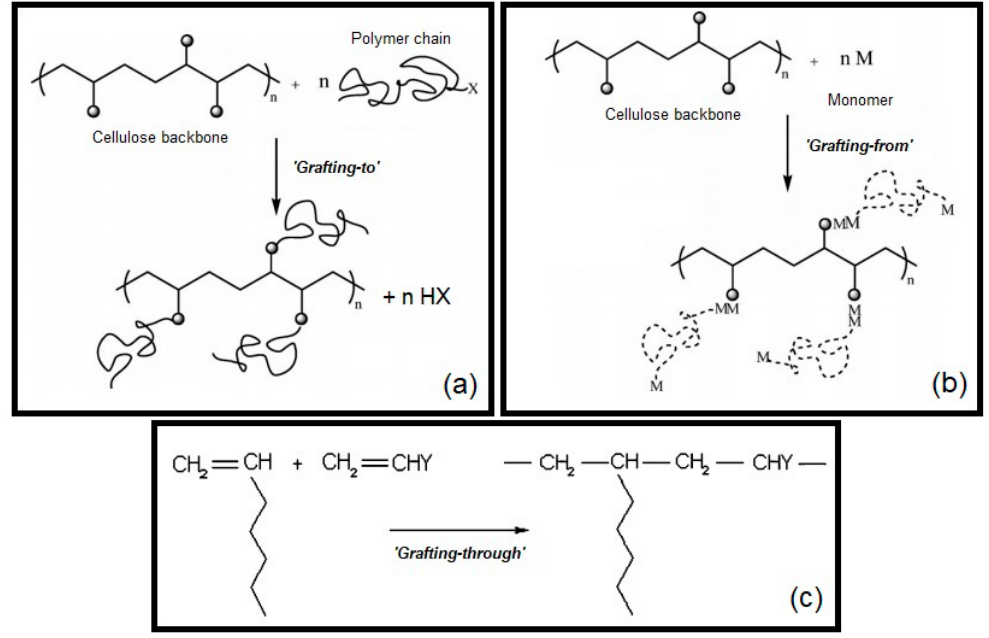
Figure 1. Schematic representation of grafting approaches: ( a ) “grafting-onto (or -to)”; ( b ) “grafting-from”; ( c ) “grafting-through”. Adapted from Roy et al. [29], with permission from The Royal Society of Chemistry, 2009.